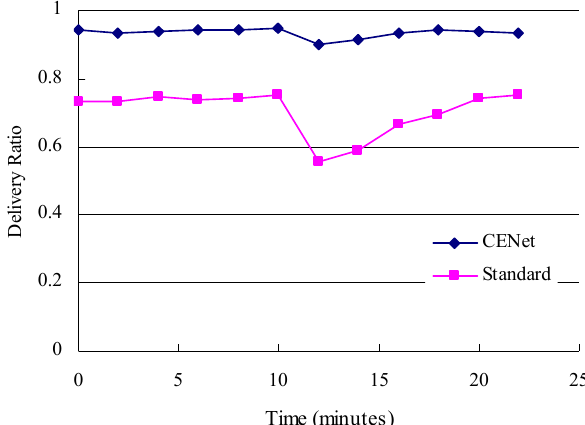
Figure 11. Robustness of CENet and standard stack when five master nodes are removed in the 10th